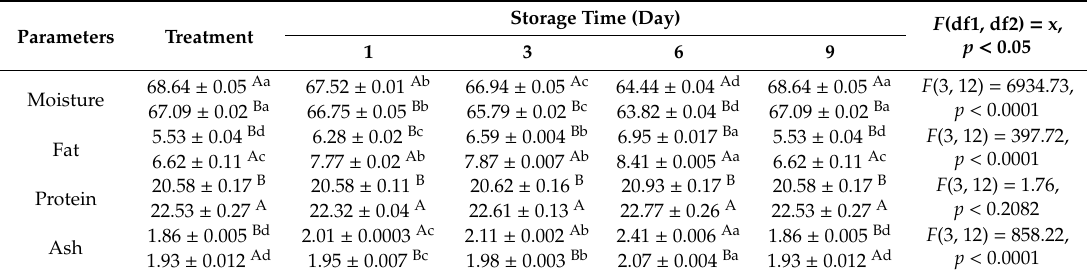
Table 5. E ff ect of vitamin E supplementation on the chemical composition (%) of goose meat during storage at 4 ◦